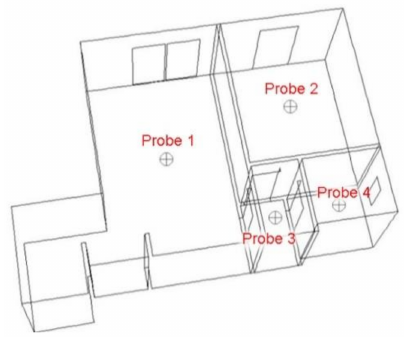
Figure 10. Control probes